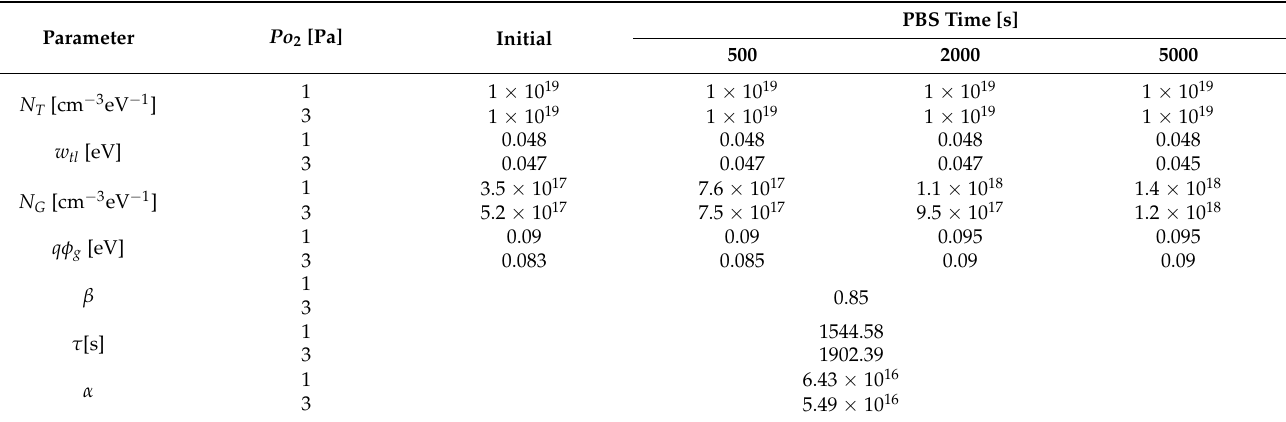
Table 2. Parameters of the DOSs under